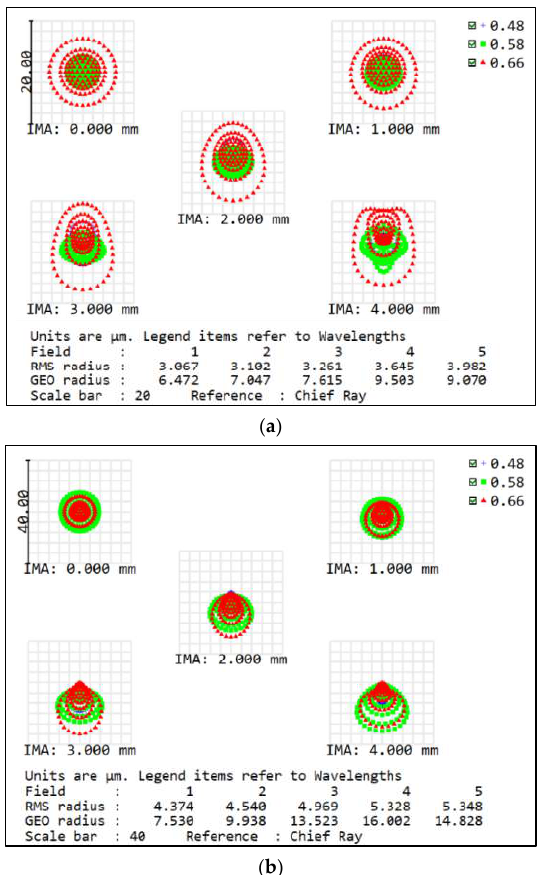
Figure 17. Spot diagrams of the concentric multi-scale zoom optical system. ( a ) Focal length f = 50 mm, ( b ) Focal length f = 100